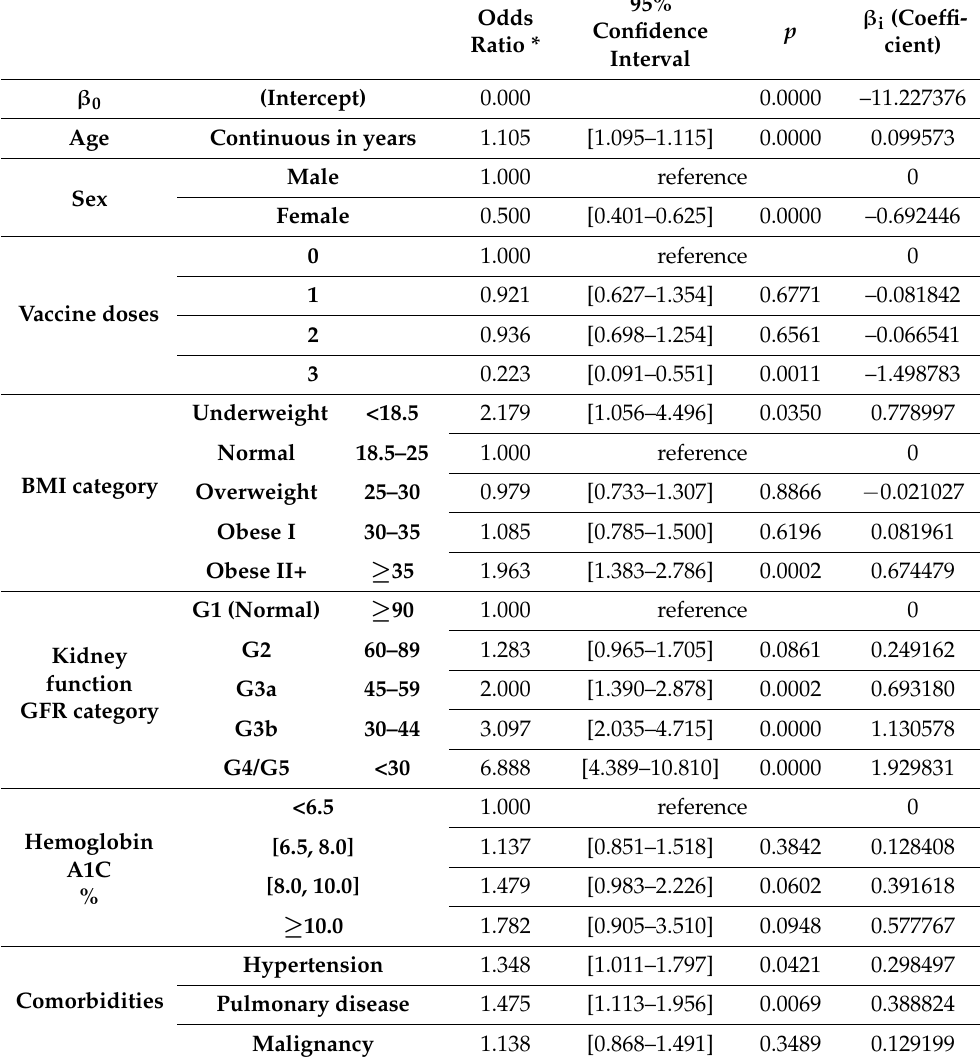
Table 3. Logistic regression model for mortality